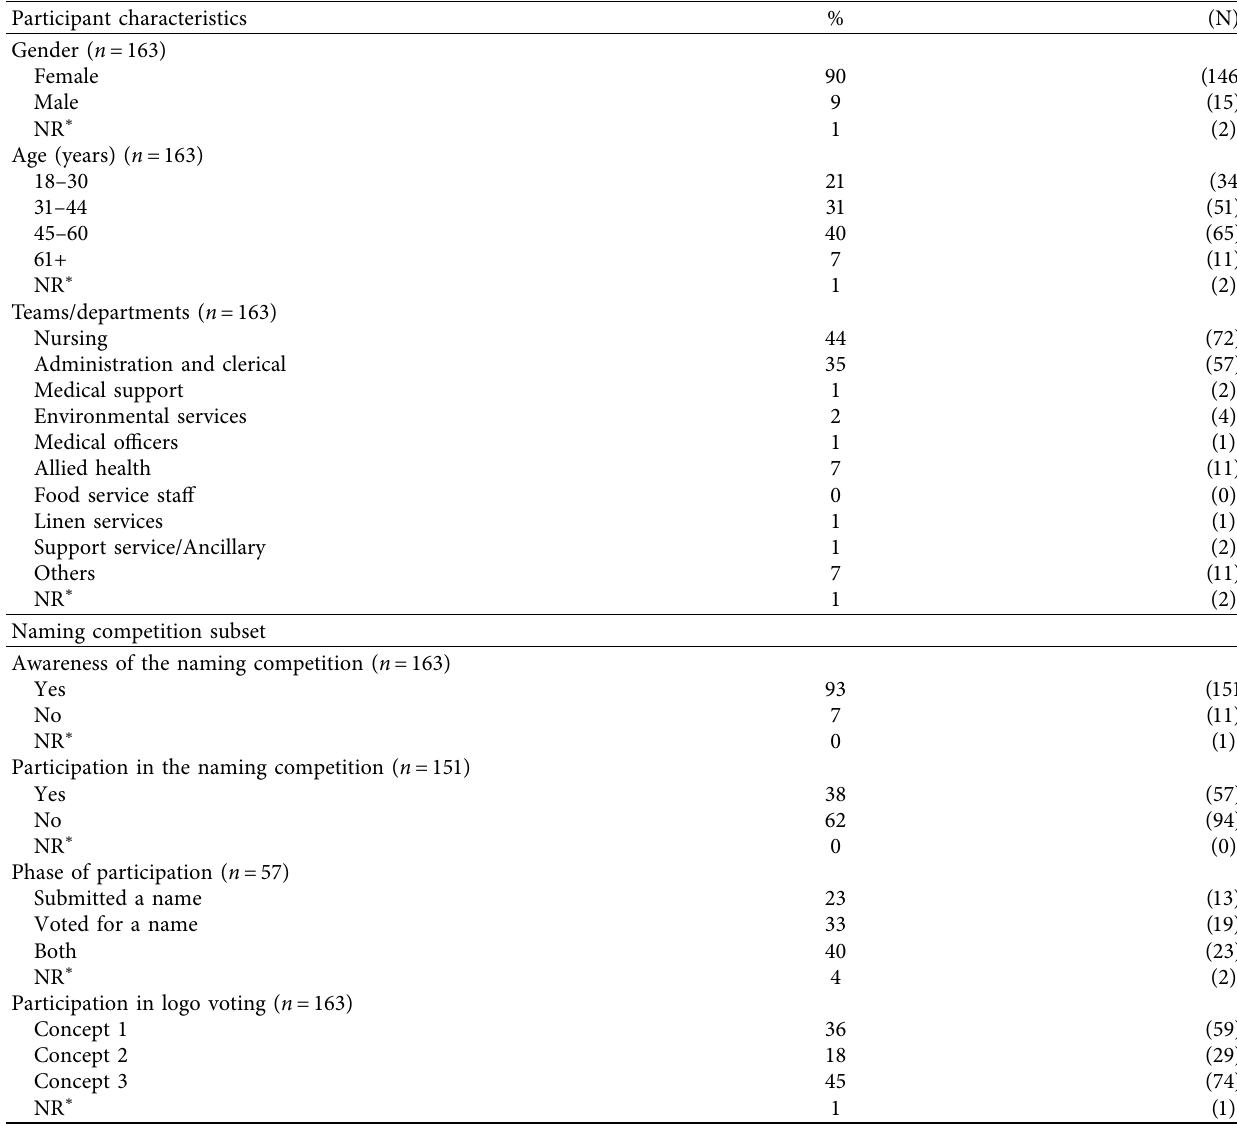
Table 1: Survey results: naming competition